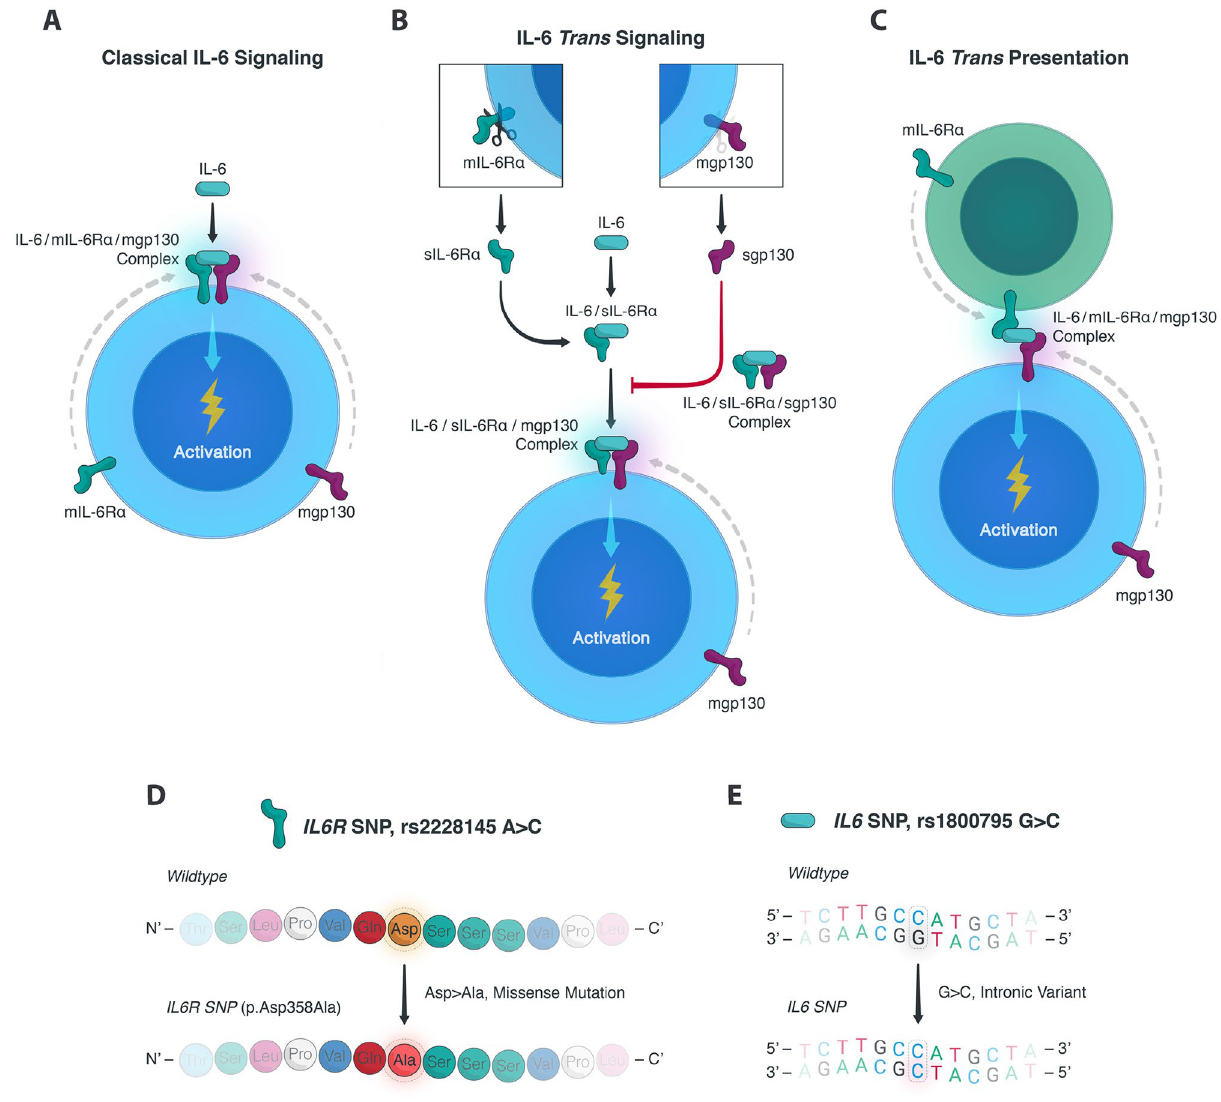
Figure 1. Illustration of the IL-6 signaling pathways and examined IL-6-related SNPs. IL-6 signalling can occur in three distinct manners. (For schematic purposes, only one of each IL-6 receptor and gp130 molecule is shown.) ( A ) Classic IL-6 signalling takes place when IL-6 directly interacts with membrane-bound IL-6R (mIL-6R) and membrane-bound gp130 (mgp130) to phosphorylate intracytoplasmic, gp130-specific secondary messengers. ( B ) IL-6 trans signalling instead occurs when solubilized IL-6R (sIL-6R) captures IL-6 and forms a complex with mgp130 to precipitate intracytoplasmic secondary signals. Notably, this mode of signalling can be inhibited by solubilized gp130 (sgp130), which only has affinity for the IL-6/sIL-6R complex and neutralizes it by preventing its binding to mgp130. ( C ) Finally, IL-6 trans presentation takes place when a secondary cell bearing mIL-6R captures IL-6 and presents it to mgp130 on a target cell to spur intracytoplasmic secondary signals in the target cell. To appreciate the potential role of IL-6-related SNPs in kidney transplant recipients and donor transplant kidneys, we assessed the association between transplant survival outcomes and ( D ) the IL6R SNP rs2228145 A > C and ( E ) the IL6 SNP rs1800795 G > C, respectively. The IL6R SNP causes a missense mutation in IL-6R, while the IL6 SNP is in the promoter region and causes an intronic not when compared to their European cohort ( P = 0.09) 15 . Kaplan–Meier survival analyses showed that the IL6R polymorphism in the donor was significantly associated with a reduced risk for acute rejection during follow-up (Fig. 2A; log-rank P = 0.003). After the complete follow-up, the incidence of biopsy-proven rejection was 38.9% in the reference AA genotype group, 32.8% in the heterozygous AC genotype group, and 24.9% in the homozy- gous CC genotype group, respectively. In univariate analysis, the IL6R SNP in the donor was associated with a hazard ratio of 0.78 per C-allele (95%-CI 0.67–0.90; P = 0.001) for biopsy-proven rejection. Kaplan–Meier sur- vival analyses for the IL6R polymorphism in the donor were re-estimated for patients transplanted in the 1990s and 2000s as immunosuppression has evolved through time and this could impact the risk of rejection. In these subgroups, the significance was maintained in patients transplanted in the 1990s (Figure S1; P = 0.016), while a